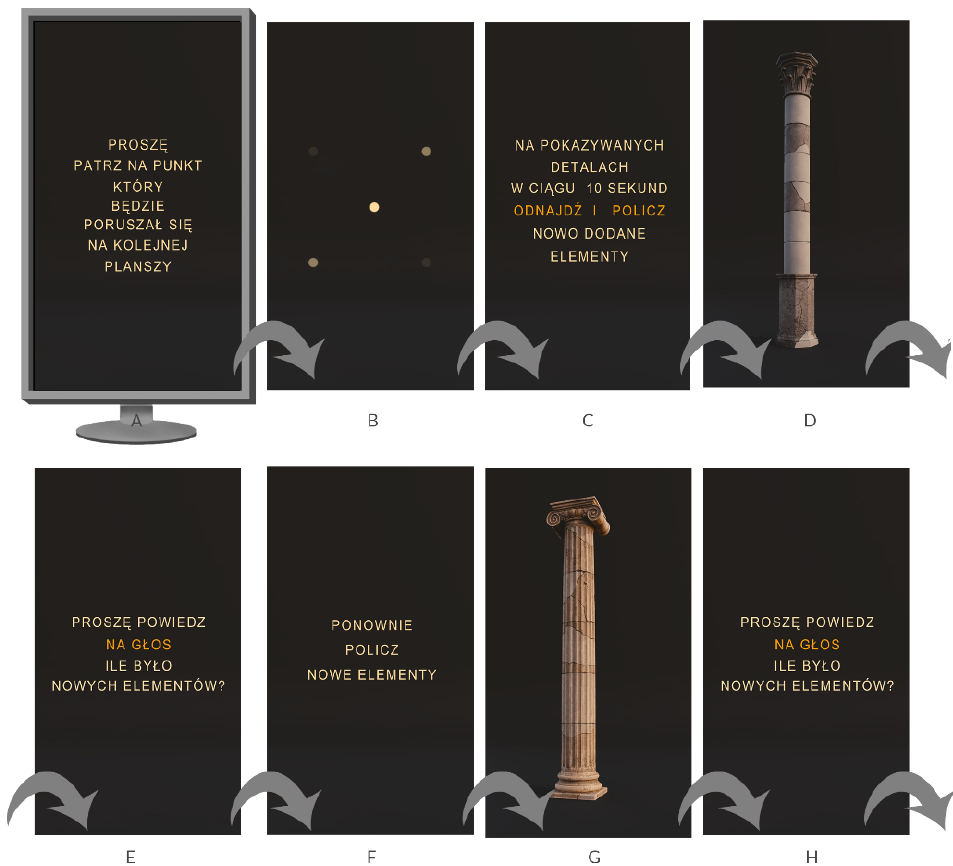
Figure 3. The course of the experiment (as presented during the experiment-in Polish). ( A , B ) Calibration section. ( C , F ) Separator boards with instructions. ( D , G ) Illustrations/stimuli (displayed for 10 s). ( E , H ) Separator boards with instructions—when the volunteer answered, another board was displayed. (translation: ( A ) Please look at the point that will move on the next board. ( C ) On the details shown, within 10 s find and count newly added elements. ( E , H ) Tell us out loud how many new items there were. ( F ) Recount new items).